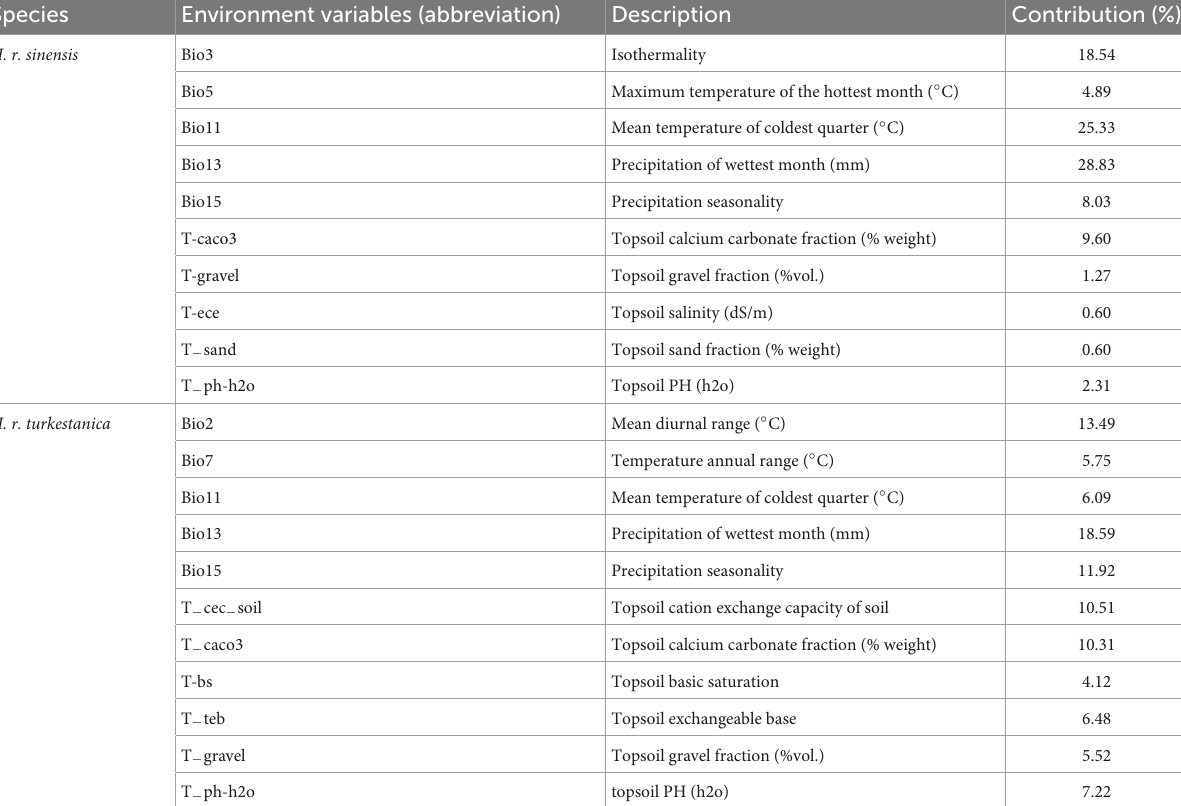
TABLE 1 Environment variables used for modeling the habitat suitability distribution of H. r. sinensis and H. r. turkestanica and variables’ contribution. Species